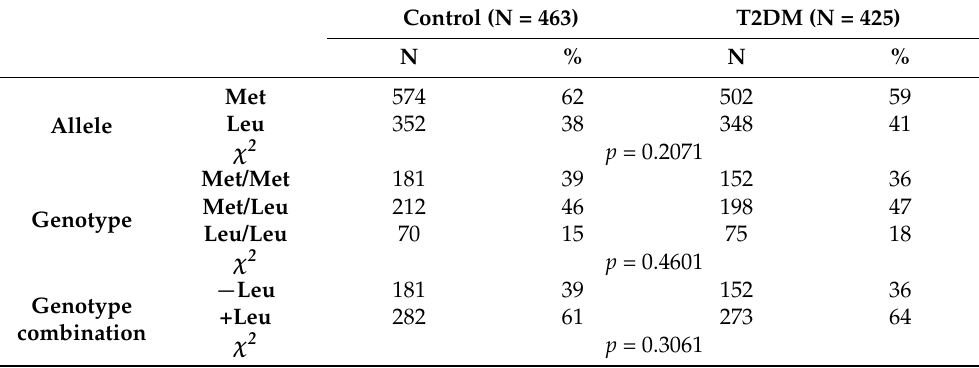
Table 1. Allele-, genotype-, and genotype combination frequencies in control and T2DM